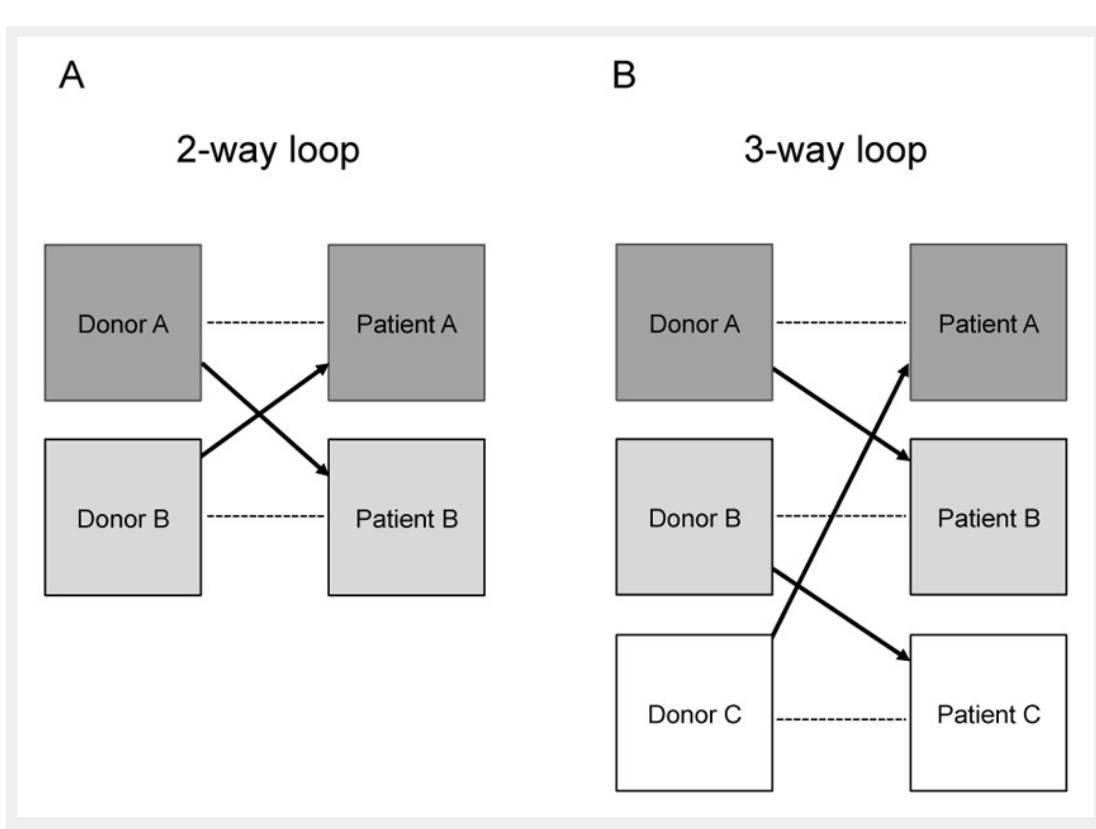
Exchange strategies in kidney paired donation: A conventional two-way loop exchange between two incompatible donor-recipient pairs (A) a three-way loop exchange among three incompatible donor-recipient pairs (B). Multi-way loops can be arranged with three, four, five or more